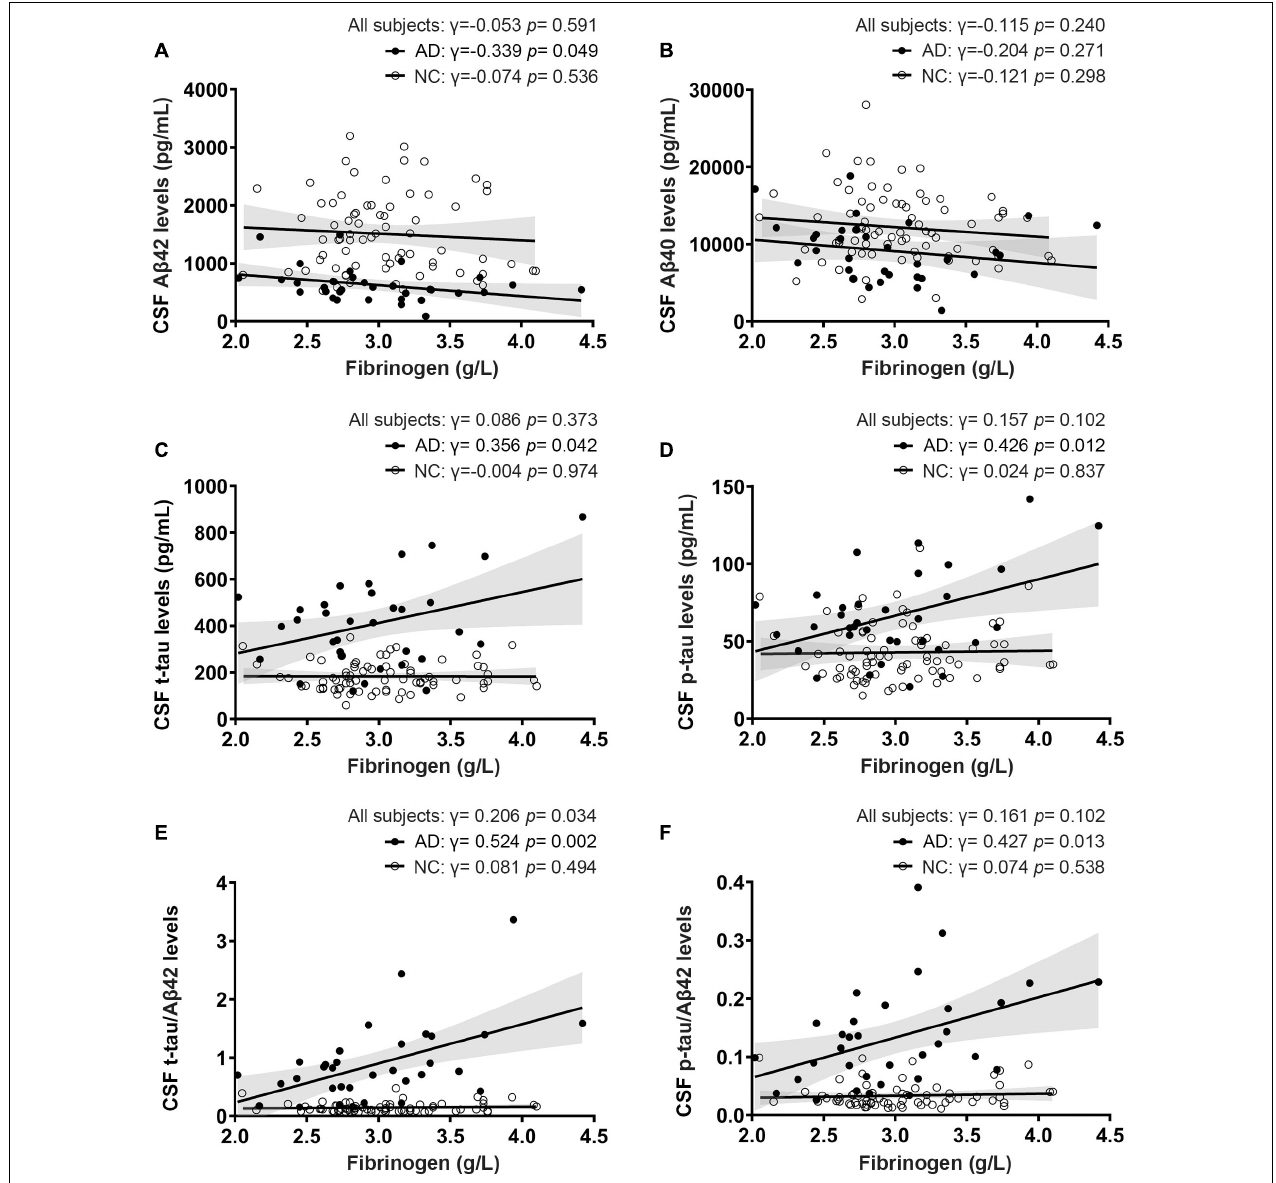
FIGURE 3 | Correlations between fibrinogen levels with CSF A β levels (A,B) , tau levels (C,D) , and tau/A β 42 levels (E,F) in AD patients and normal controls